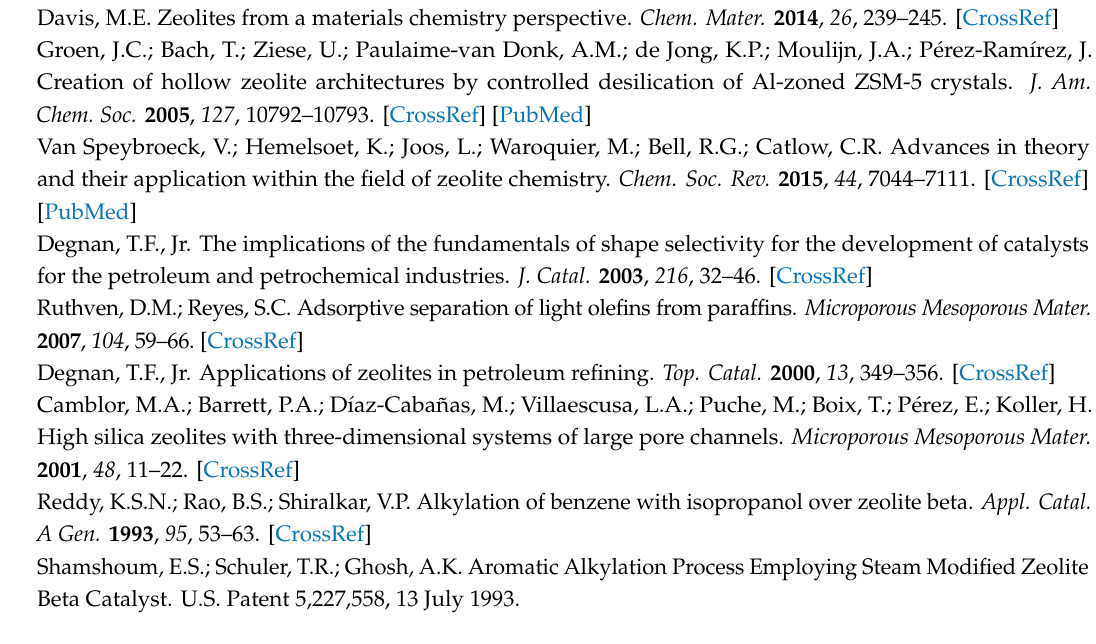
Table S1: Elemental analysis and related data of YFI samples. Figure S1: 27 Al magic angle spinning nuclear magnetic resonance ( 27 Al MAS NMR) spectra obtained from the (a) YFI-A, (b) YFI-B, (c) YFI-C, and (d) YFI-D. Figure S2: 29 Si MAS NMR spectra obtained from the (a) YFI-A, (b) YFI-B, (c) YFI-C, and (d) YFI-D. Figure S3: Powder X-ray di ff raction patterns obtained from the (a) deAl-YFI-A(51), (b) deAl-YFI-B(57), (c) deAl-YFI-C(55), and (d)